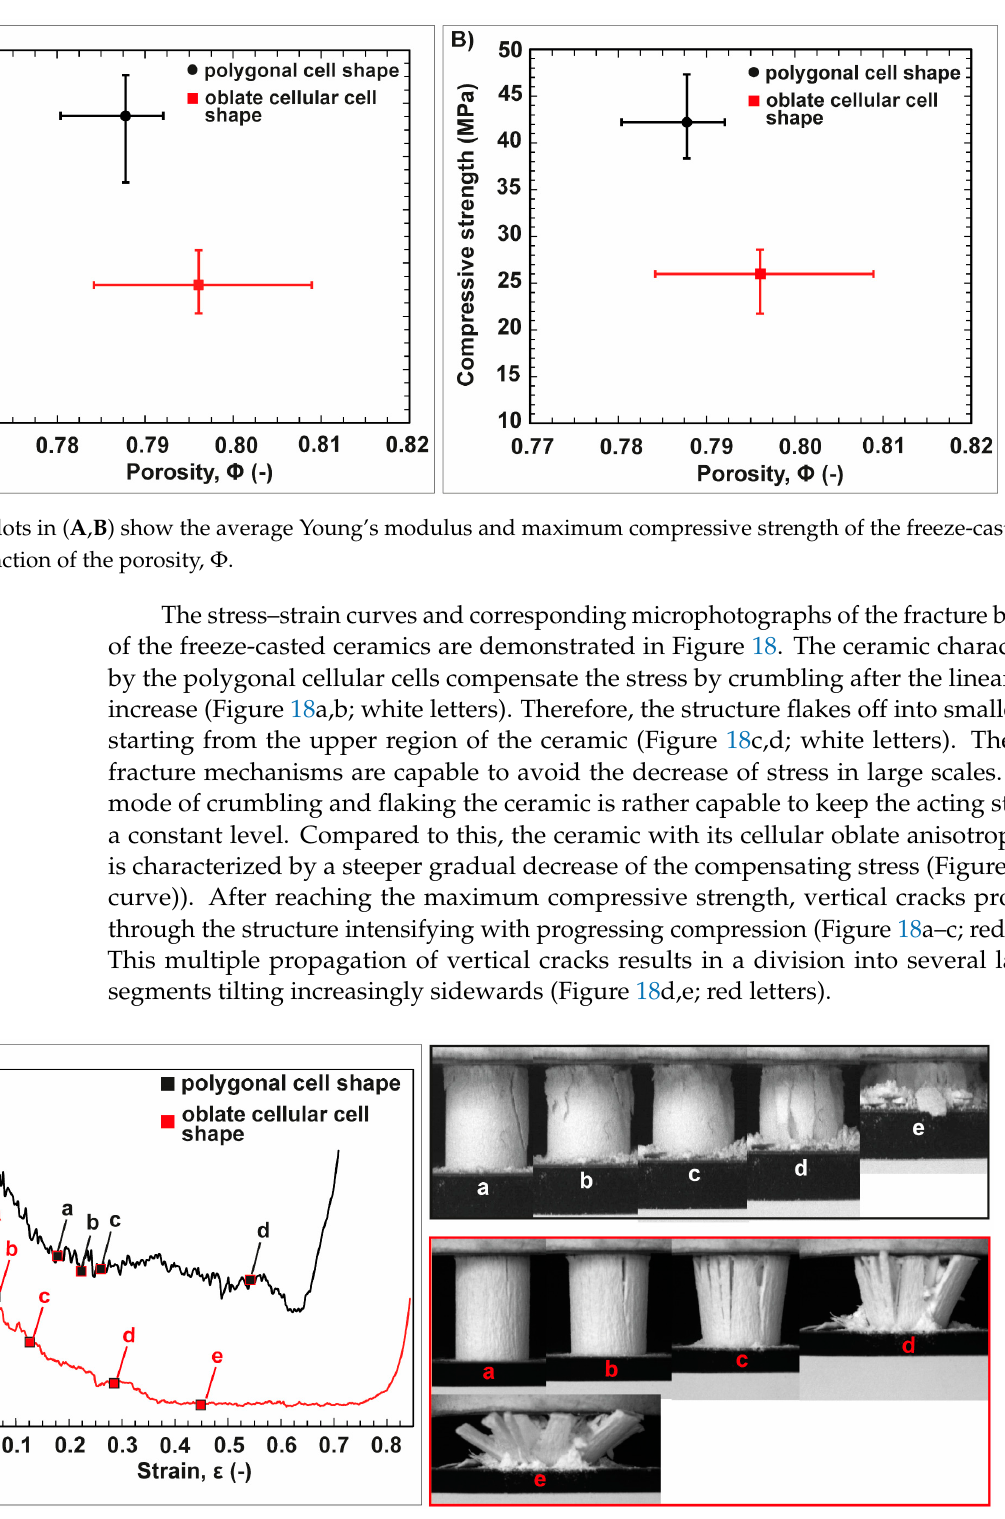
Figure 18. The stress ( σ )-strain ( ε ) curves and the corresponding microphotographs of the fracture behavior of the freeze- casted ceramics. The ceramics including the polygonal cells compensate stress by a progressive interplay of crumbling and flaking (a–e, white letters). An intensive lath-like segmentation (a–e, red letters) can be observed for the ceramics being characterized by cellular oblate anisotropic cells.